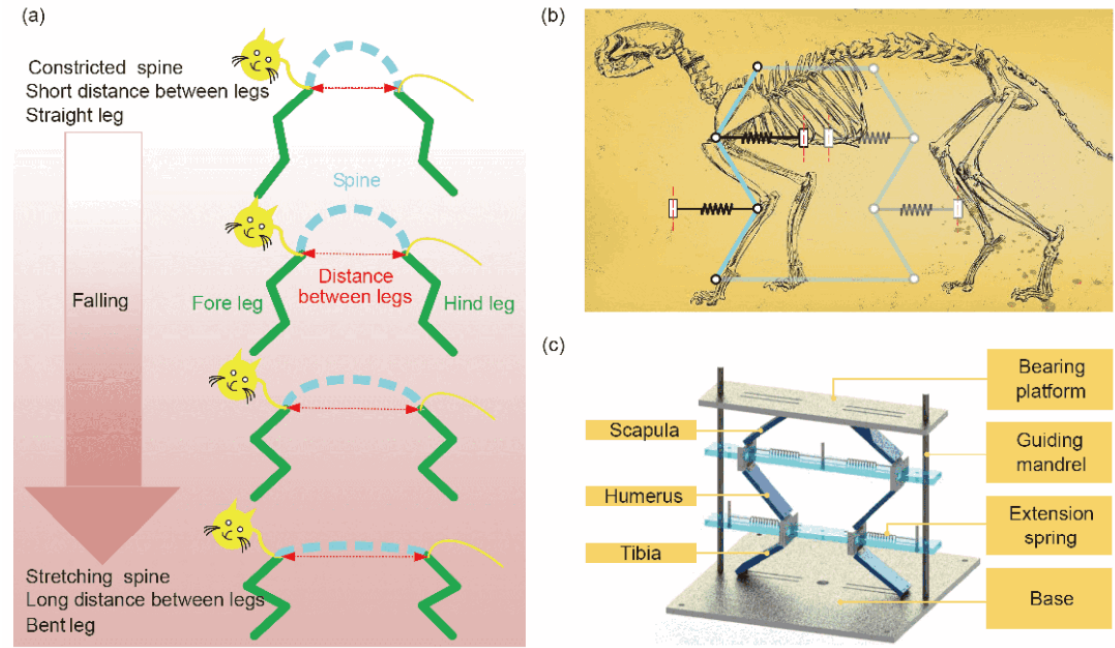
Figure 11. ( a ) Body posture adjustment after cats fall, ( b ) bionic design of polygonal structure, ( c ) bionic vibration isolation device with polygonal structure [38].